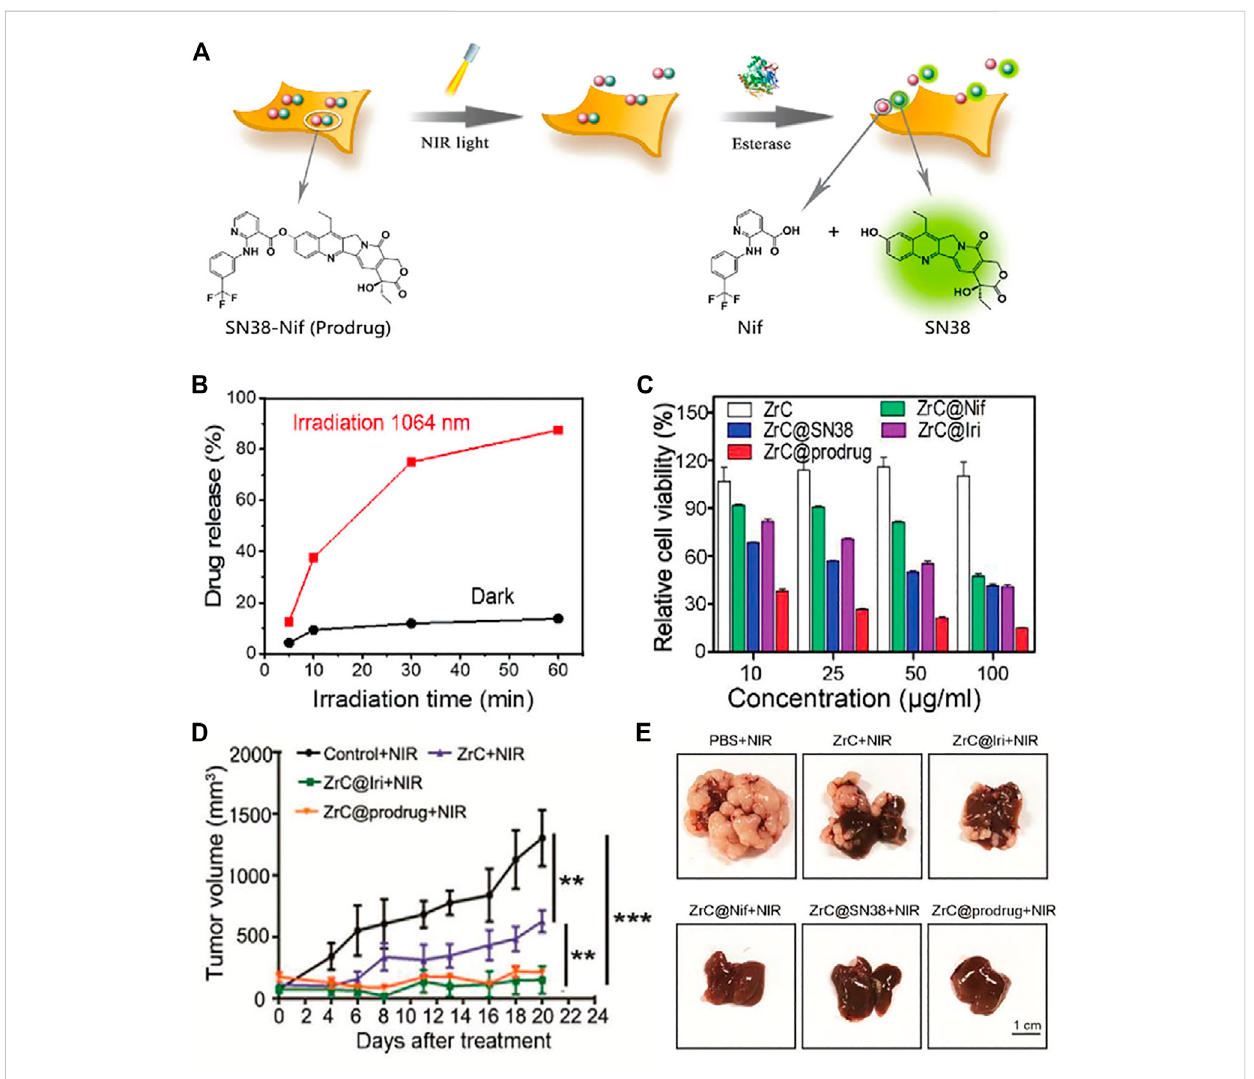
FIGURE 3 (A) Schematicillustrationofrelease andactivation ofSN38-Nif basedonZrC@prodrug. (B) Drugreleasepercentagewithandwithout irradiation. (C) Relative cell viability of SMMC-7721 in different groups. (D) Growth of tumor volume in different treatment groups. (E) Digital photographs of tumor after treatments in different groups. (Adapted with permission from Liu S et al., 2020. Copyright 2020